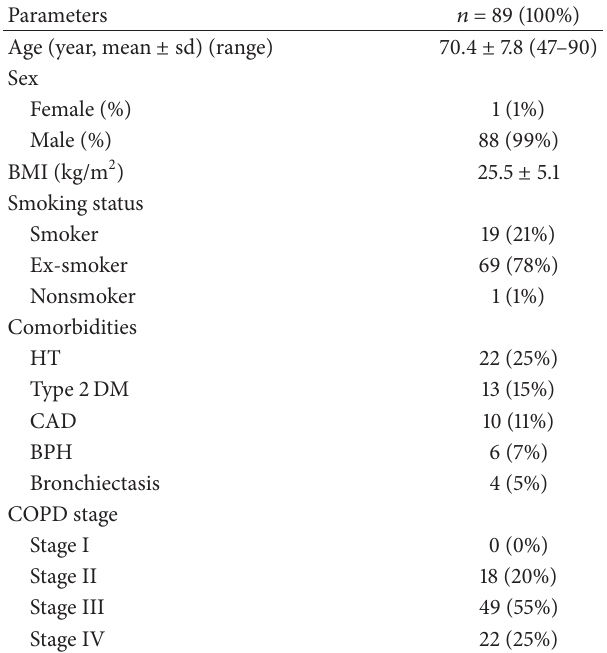
Table 1: The demographic characteristics of patients.